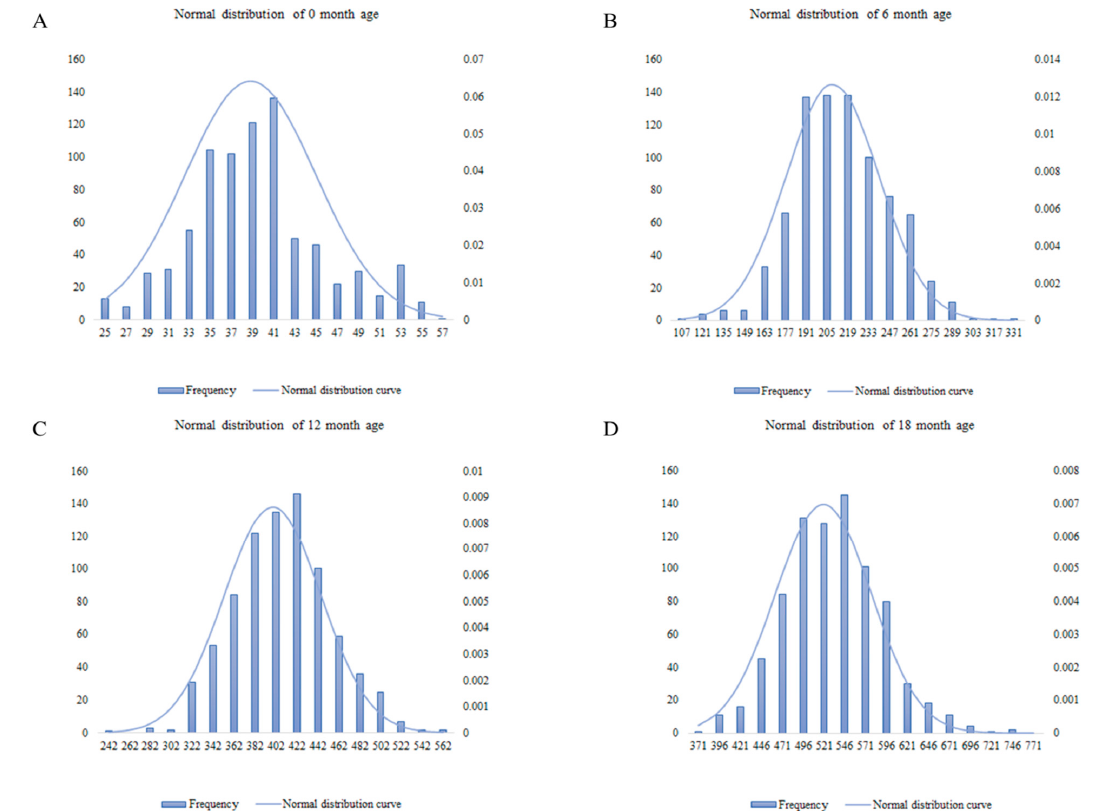
Figure 1. Normal distribution of bovine body weight of the test population at different months of age. A shows the normal distribution of body weight at 0 months of age; B shows the normal distribution of body weight at 6 months of age; C shows the normal distribution of body weight at 12 months of age; D shows the normal distribution of body weight at 18 months of age. In the figure, the abscissa represents weight, the left ordinate represents frequency, and the right ordinate represents normal function values.